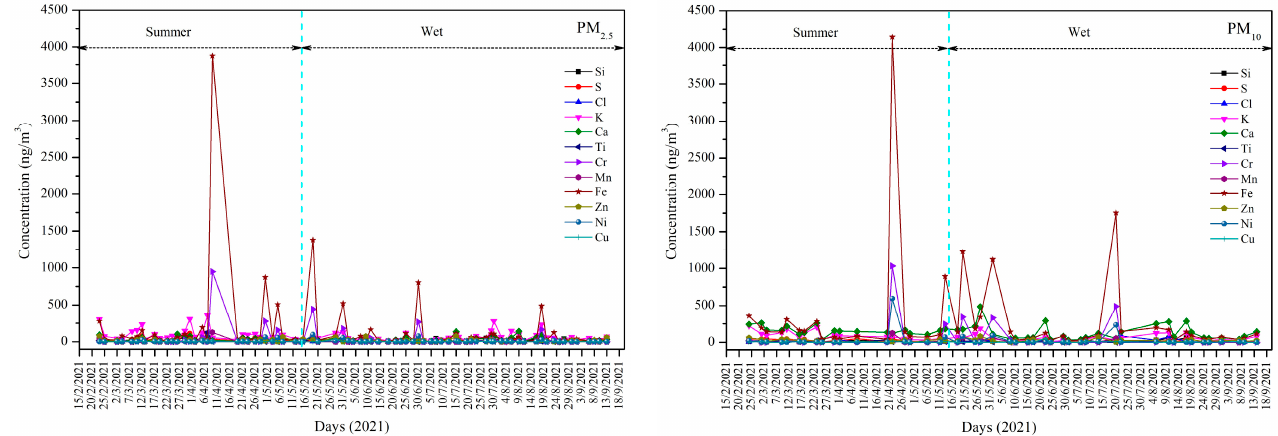
Figure 3. Variation of elements concentrations of PM 2.5 and PM 10 samples over Pathum Thani Province from 18 February to 14 September 2021.